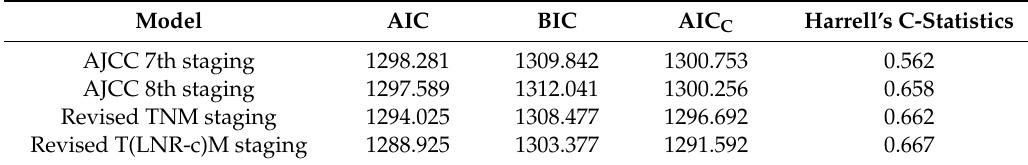
Table 5. Comparison of predictive power of each staging